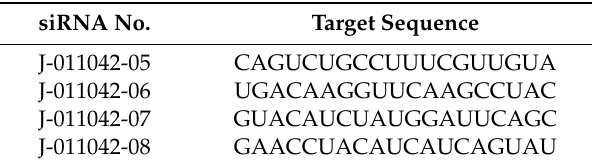
Table 1. Gap junction protein alpha 1 ( GJA1 ) short interfering RNA target sequences. siRNA